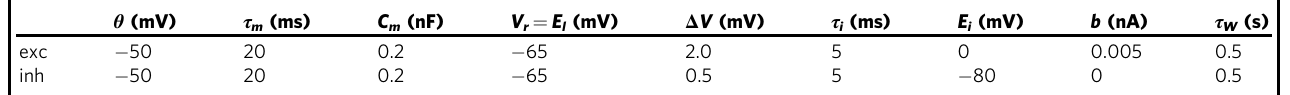
Table 1 Neuronal parameters de fi ning the two-population regular and fast-spiking populations model. θ